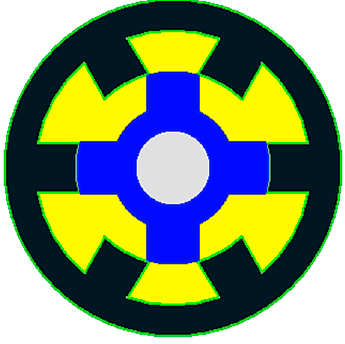
Figure 1. Three-phase 6/4 SRM layout’s construction. The voltage equation of each motor phase is given by